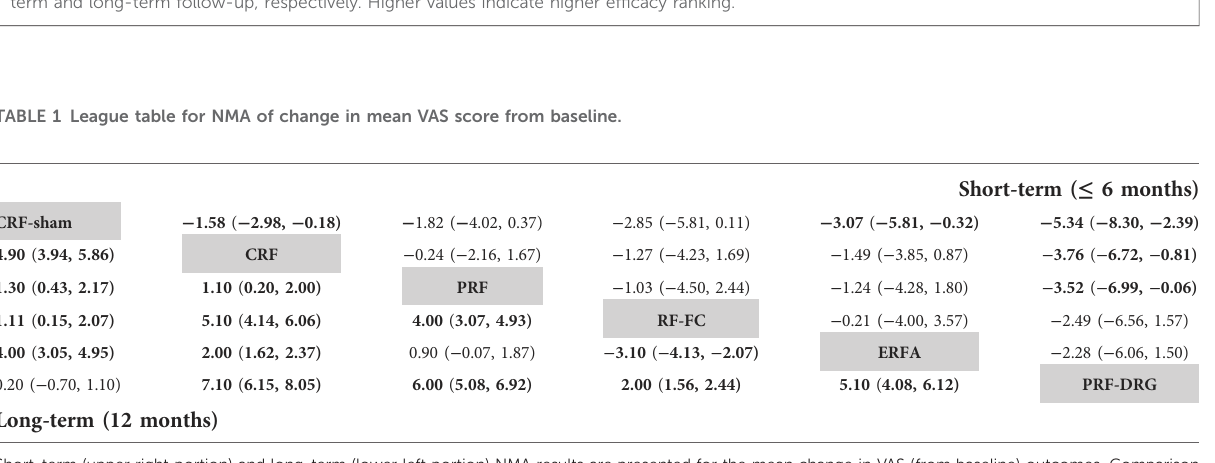
FIGURE 4 Scatter plot of the SUCRA for each intervention. The horizontal and vertical coordinates are the area under the SUCRA for each intervention at short- term and long-term follow-up, respectively. Higher values indicate higher ef fi cacy ranking.